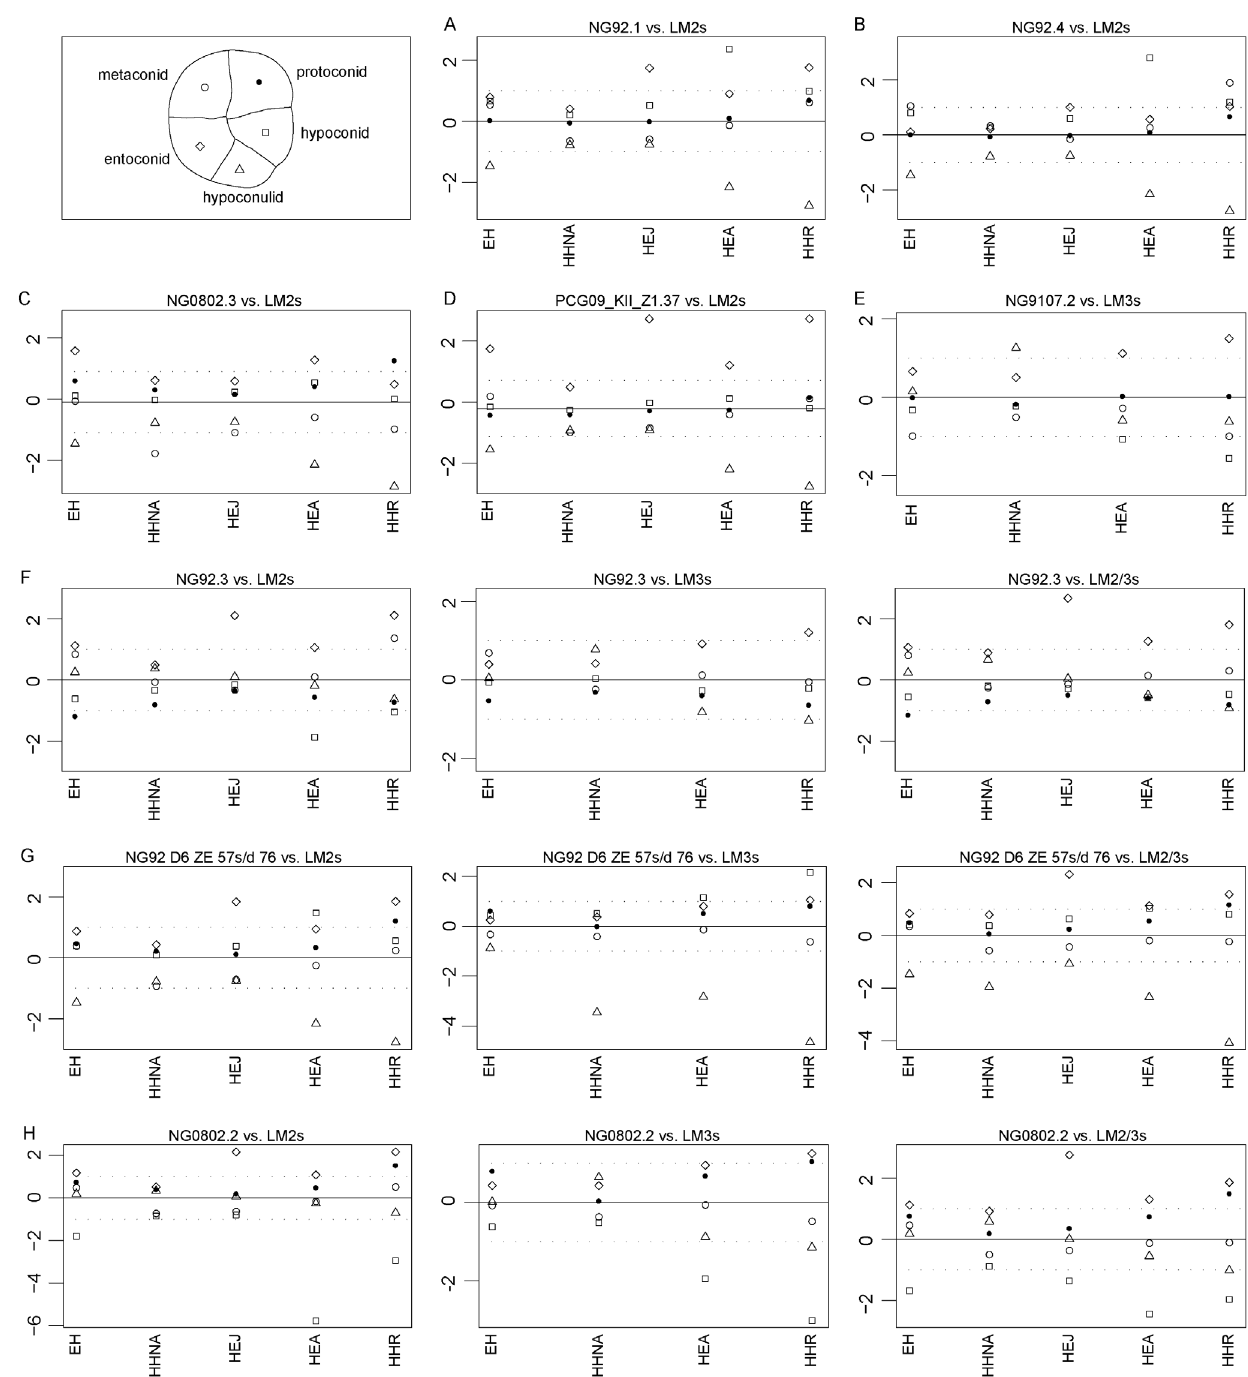
Figure 4. Adjusted Z-score graphs of relative molar cusp area in NG92.1 (A), NG92.4 (B), NG0802.3 (C), PCG09_KII_Z1.37 (D), NG9107.2 (E), NG92.3 (F), NG92.D6 ZE 57s/d 76 (G), and NG0802.2 (H) from the new Javanese fossil human dental sample compared to the LM2 and/or LM3 figures from five extant and fossil human samples. The full line passing through the zero represents the mean and the dotted lines correspond to the estimated 95% limit of variation expressed for each group. Each symbol corresponds to a distinct cusp base area for the tested specimen.